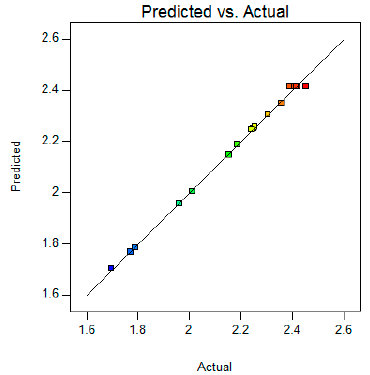
Figure 6. Linear correlation plot between actual and predicted values for the BA yield.